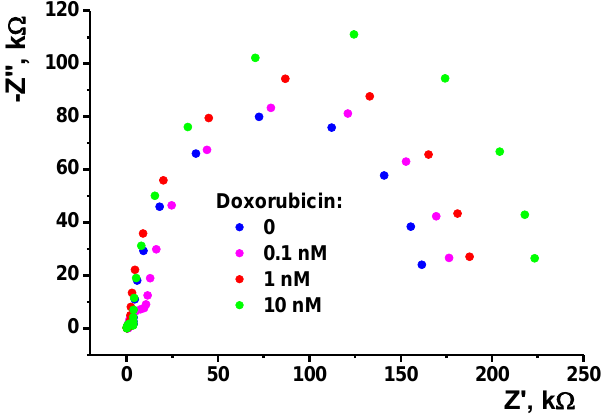
Figure 6. The Nyquist diagram obtained on the glassy carbon electrode covered with poly(Azure B– proflavine) and DNA previously mixed with doxorubicin solution (2 μL of the mixture containing 1.0 mg/mL DNA in 0.1 M HEPES + 0.03 M NaCl, pH = 7.0). Measurements in 0.025 M PB + 0.1 M KCl, pH = 7.0, in the presence of 10 mM [Fe(CN) 6 ] 3-/4- .